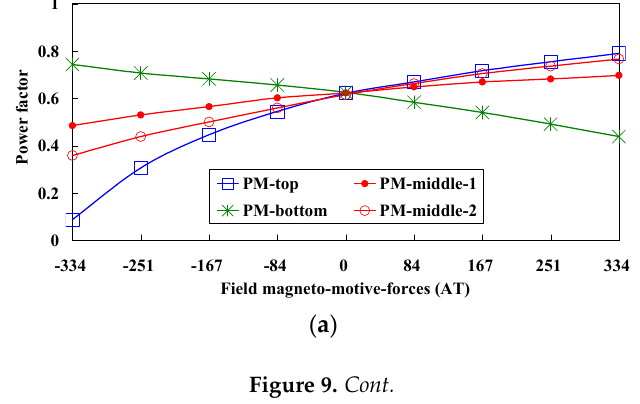
Figure 9. Cont. Figure 9.